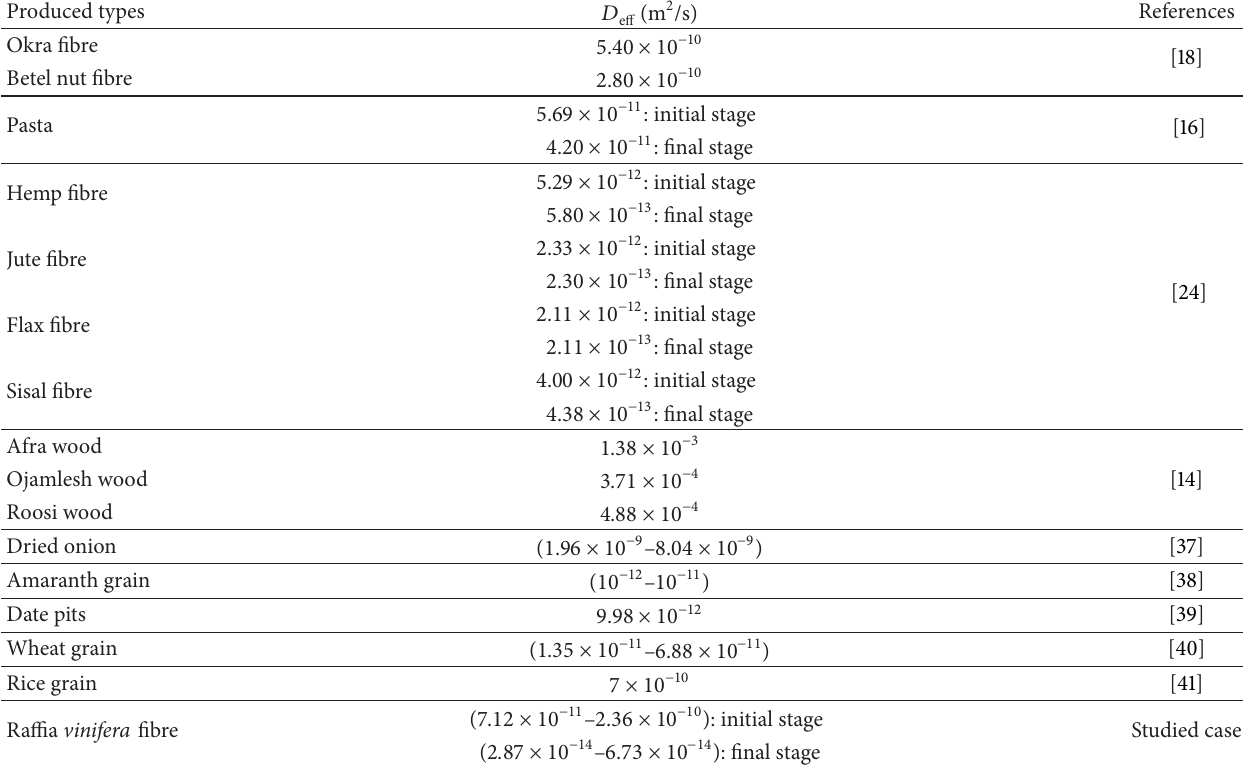
Table 7: Comparison of the effective diffusion coefficients during water